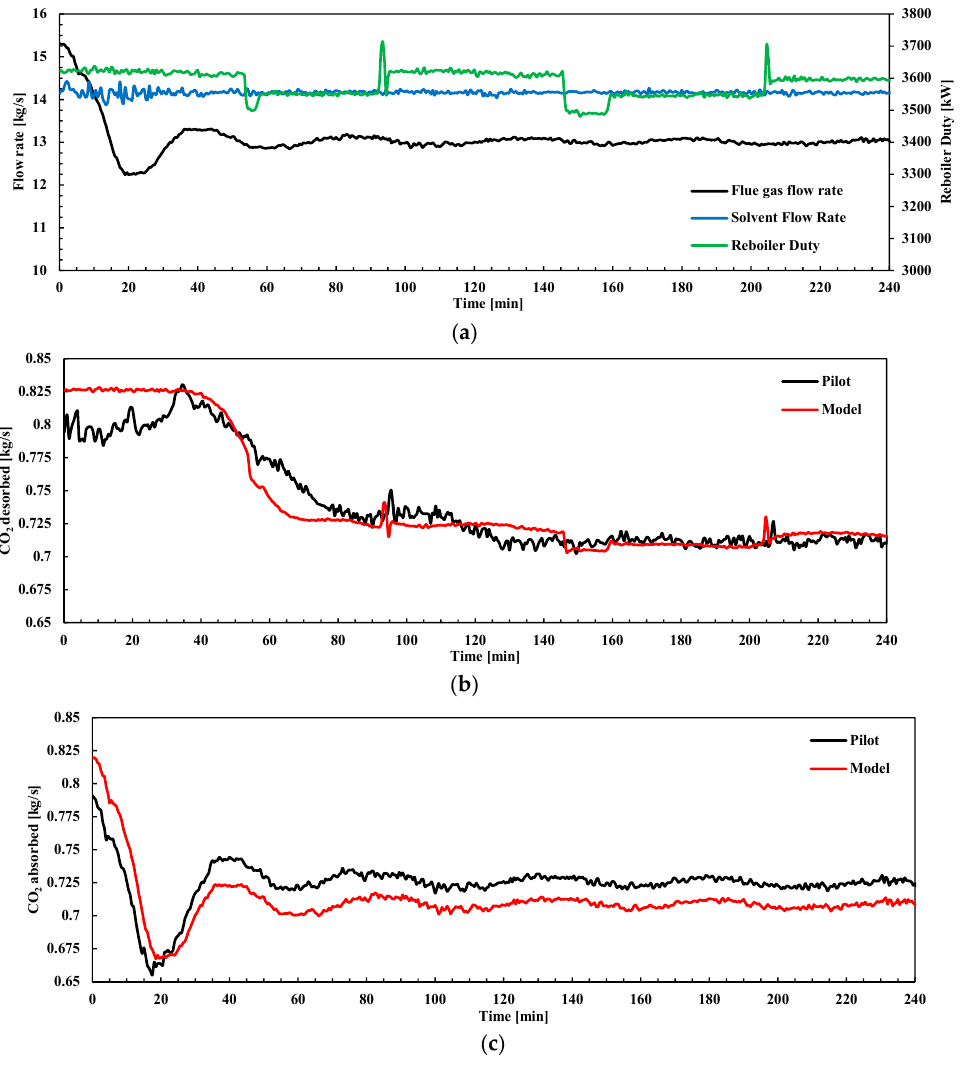
Figure 5. ( a ): Main inputs to the plant for test with flue gas flow rate set-point reduction (kg/s). Rich solvent flow rate from absorber (kg/s) and reboiler duty (kW); ( b ): Pilot plant transient response and model output trajectory for CO 2 product flow rate F prod or CO 2 desorbed (refer to FT3 in Figure 1); ( c ): Pilot plant transient response and model output trajectory for CO 2 absorbed in absorber column, refer to Equation (11). The time t = 0 corresponds to the point from which the set point of flue gas volumetric flow rate was changed.